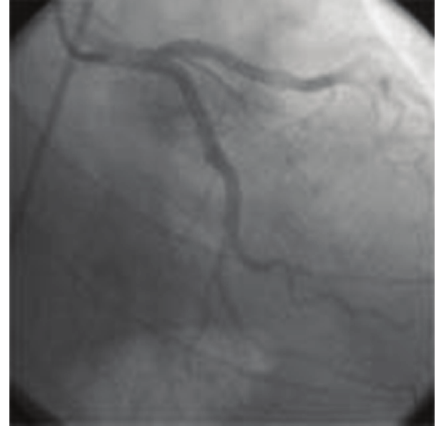
Figure 4: Left circumflex coronary artery angiogram after success- ful stent